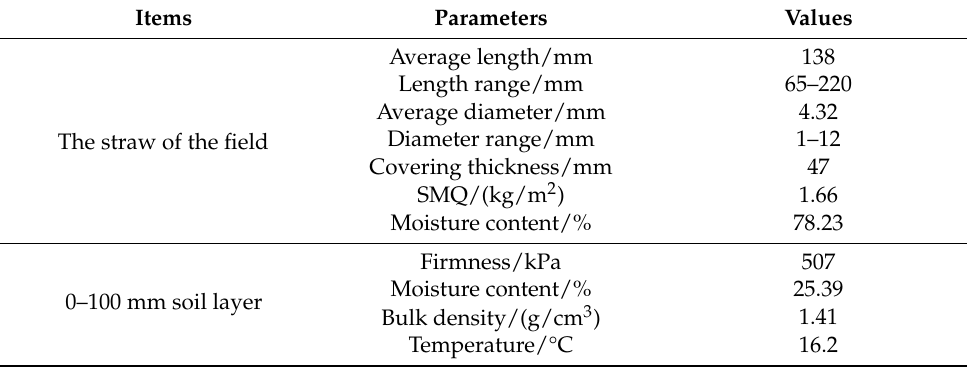
Figure 4. Field straw before operation. Table 2. Main parameters of field